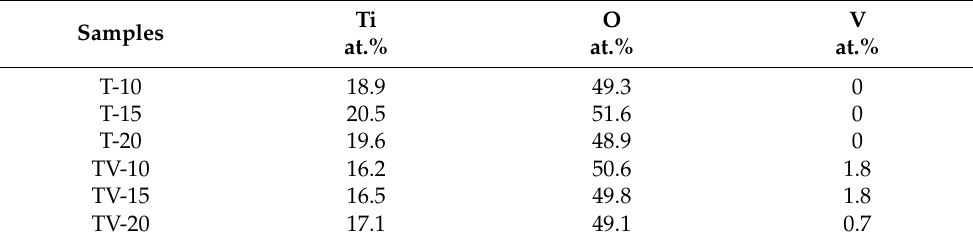
Table 2. Chemical analysis of TiO 2 nanotubes with and without vanadium oxide deposition. Samples